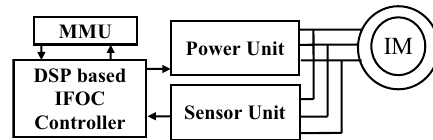
Fig. 2 IFOC based VSI-IM drive prototype